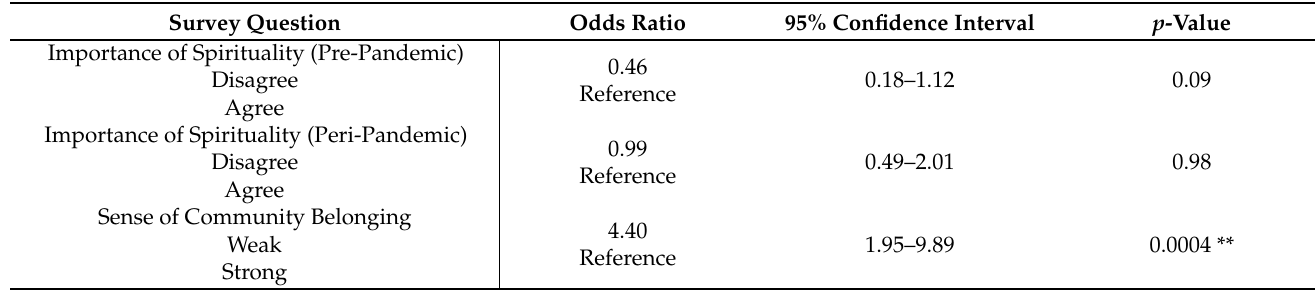
Table 3. Adjusted logistic regression of the association between the importance of spirituality and sense of community belonging with symptoms of depression (PHQ-2 score ≥ 3).